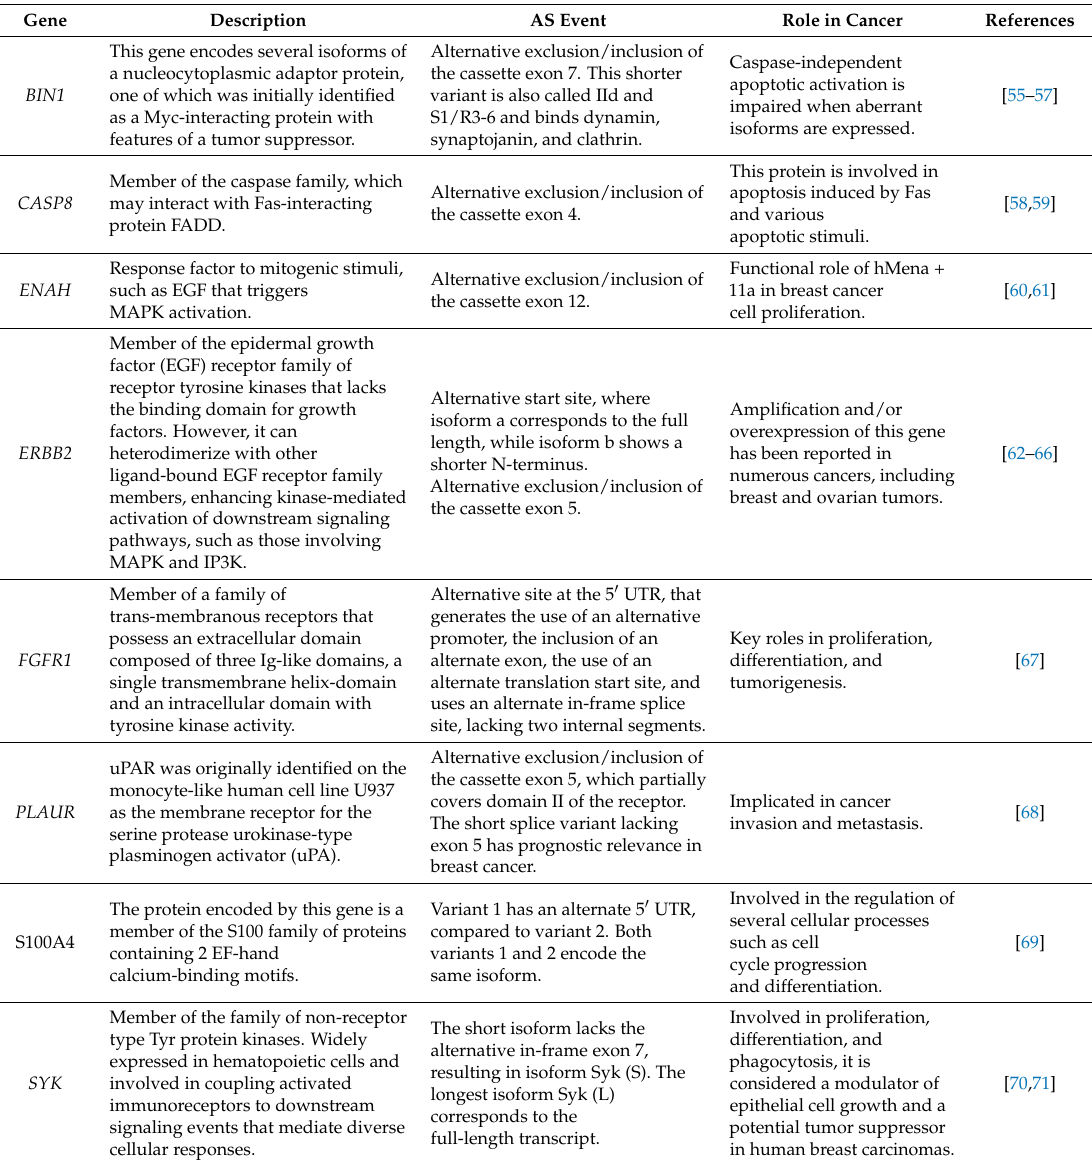
Table 1. Alternative splicing isoforms related to tumor